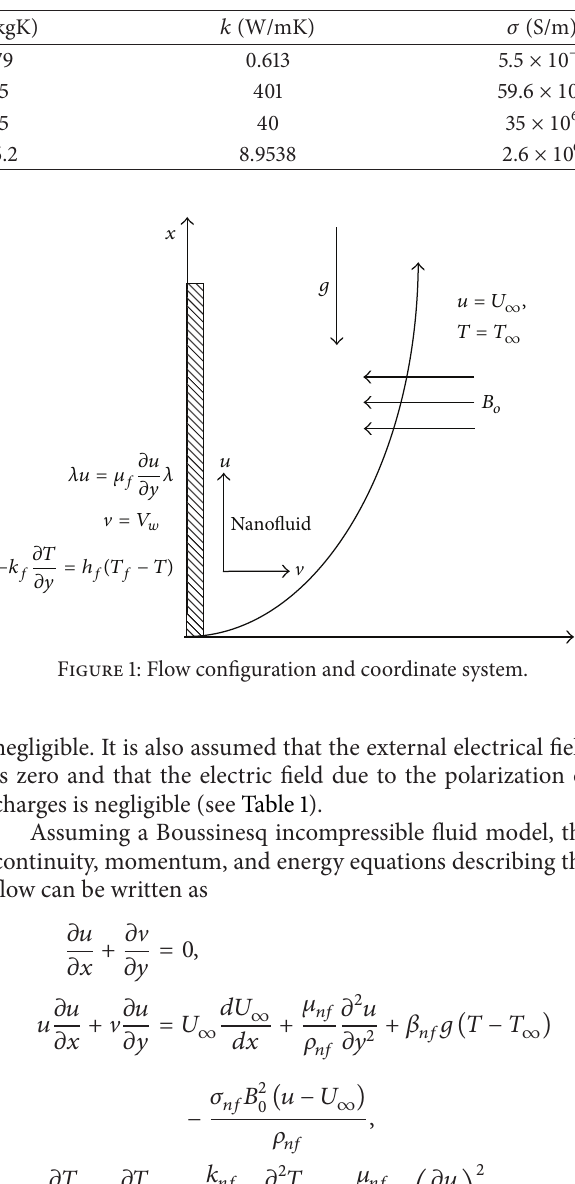
Table 1: Thermophysical properties of water and nanoparticles [23, 24].